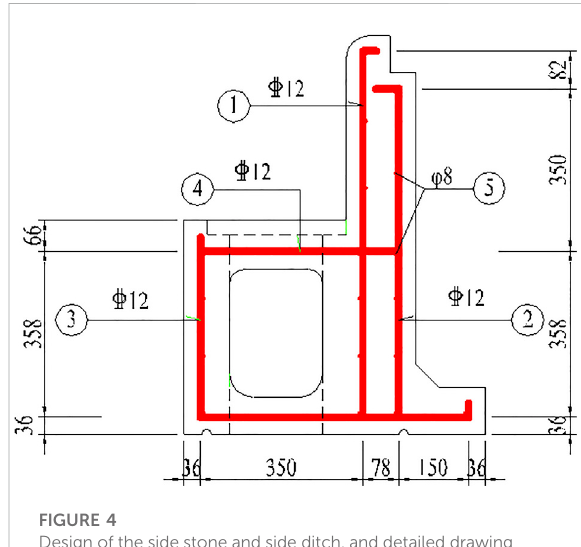
FIGURE 4 Design of the side stone and side ditch, and detailed drawing of the